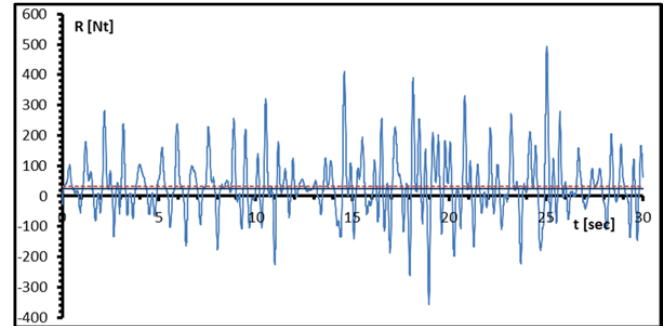
Figure 18. Resistance time series for Experiment #6.